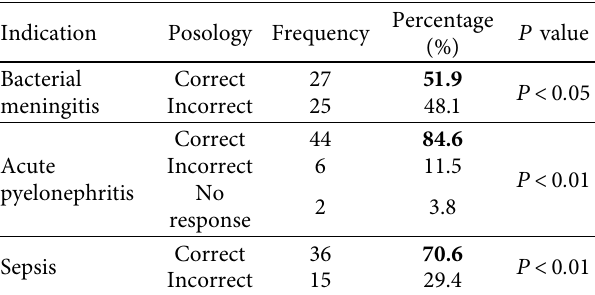
Te bold values indicate statistical signifcant results posology of ceftriaxone in the treatment of bacterial meningitis, acute pyelonephritis, and sepsis being